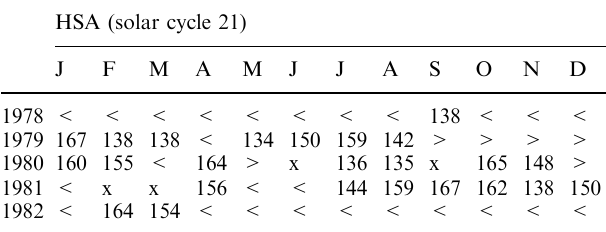
Table 1. Monthly mean sunspot numbers R for the solar maximum period 1978–1982 [ < : R < 130 (not selected), > : R > 170 (not selected), x: no data available]